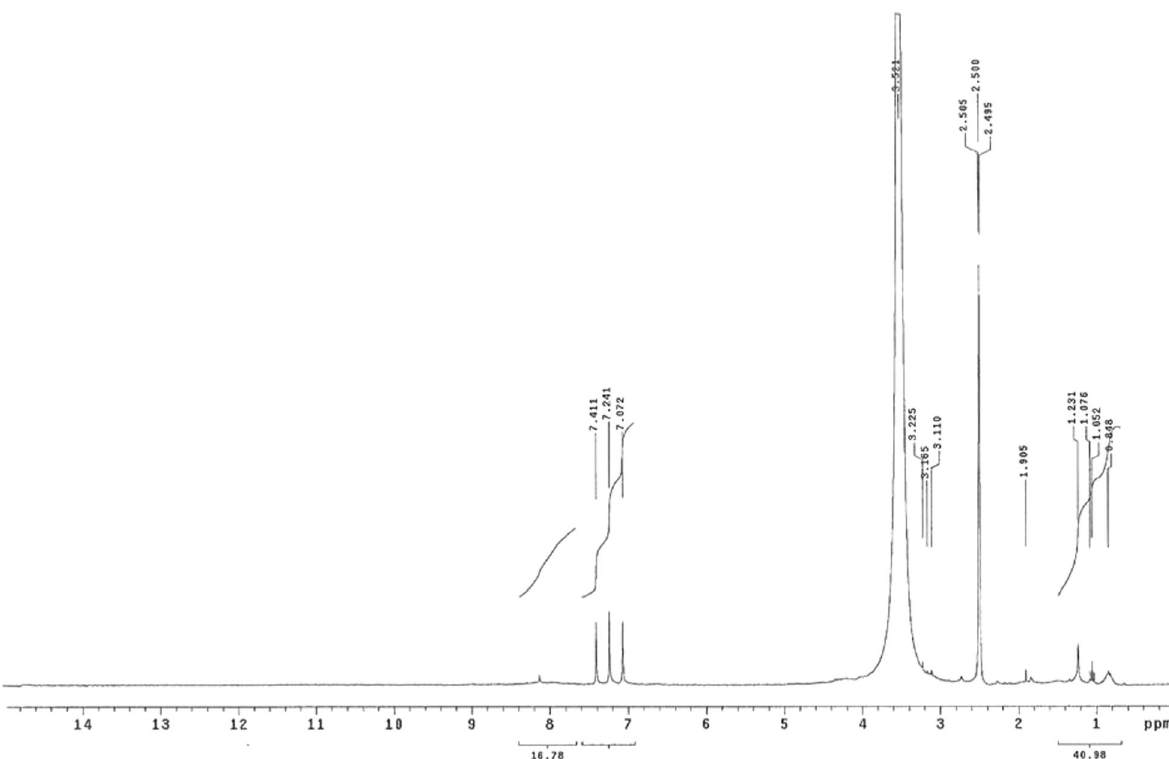
Fig. 3 1 H-NMR spectrum of the extracted sepia melanin (SM)